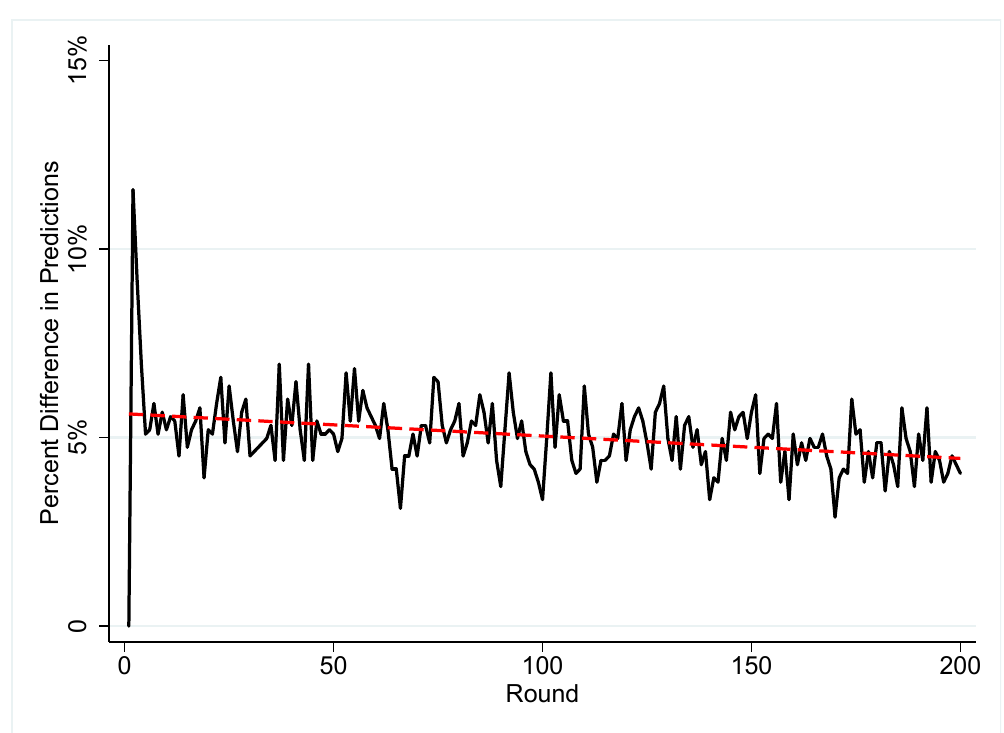
Figure 5. Convergence of RL and CBL. The red line denotes an OLS regression line of round on percent difference in